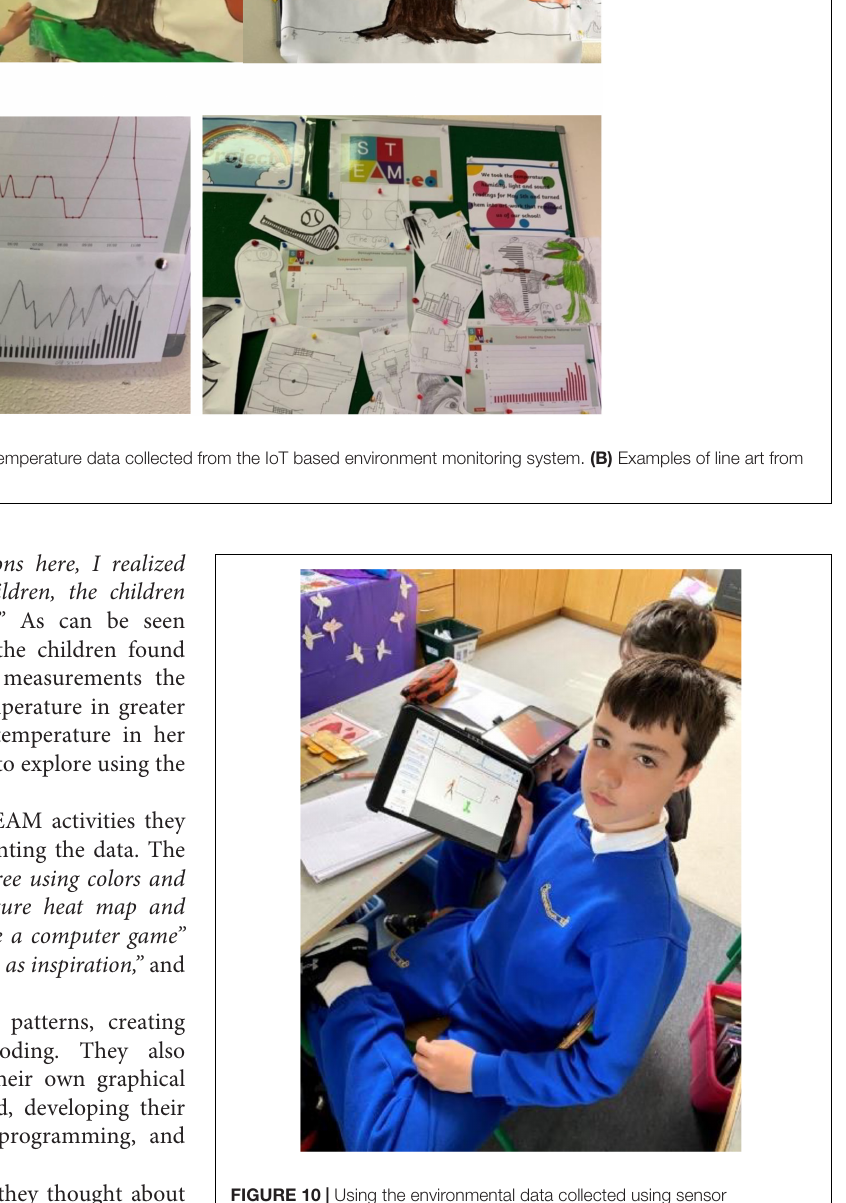
FIGURE 10 | Using the environmental data collected using sensor technologies to code computer